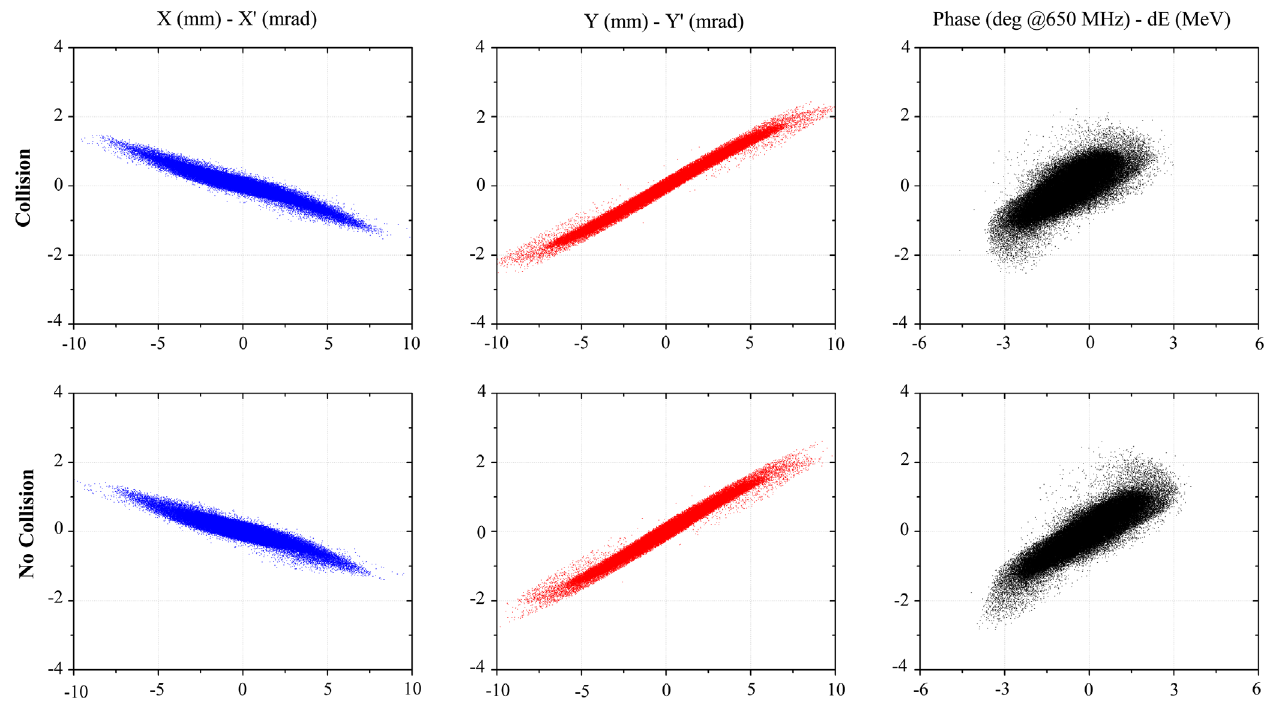
FIG. 10. Final transverse and longitudinal phase spaces at the end of the linac with and without the multiple